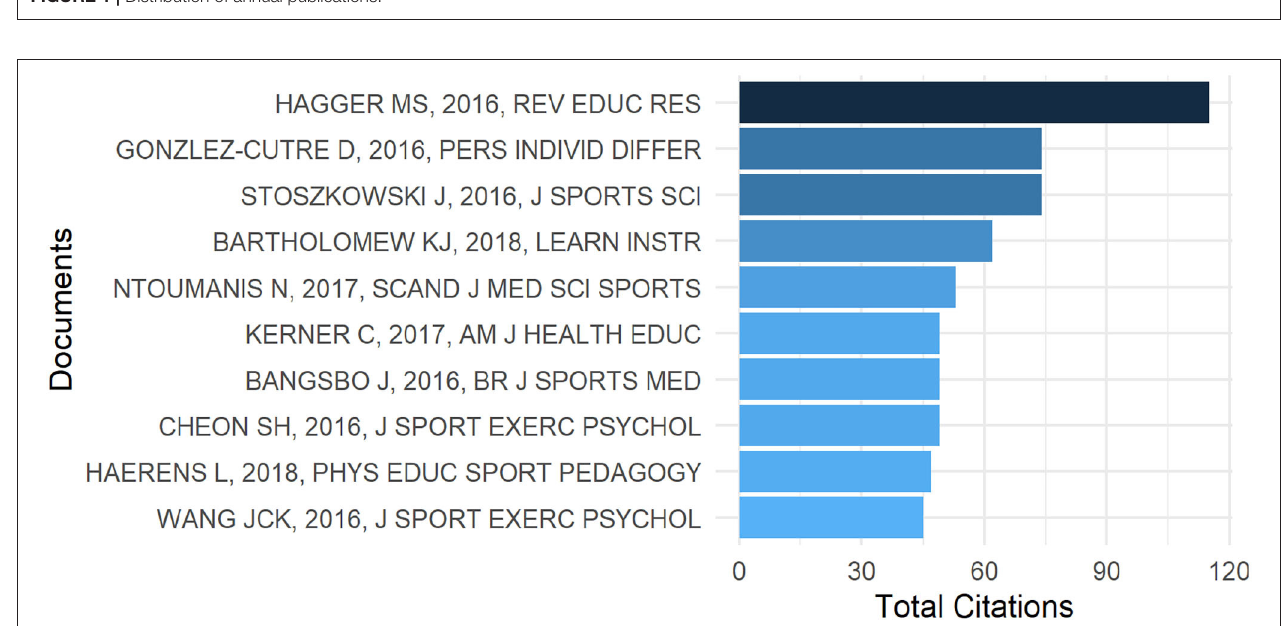
FIGURE 1 | Distribution of annual publications.